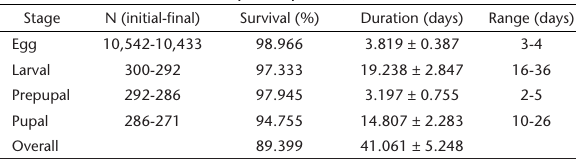
Table 1. Survival and duration of the immature stages of Spodoptera cosmioides on artificial diet under controlled conditions (25 ± 1°C, 70 ± 10% RH and 14 hour photophase).